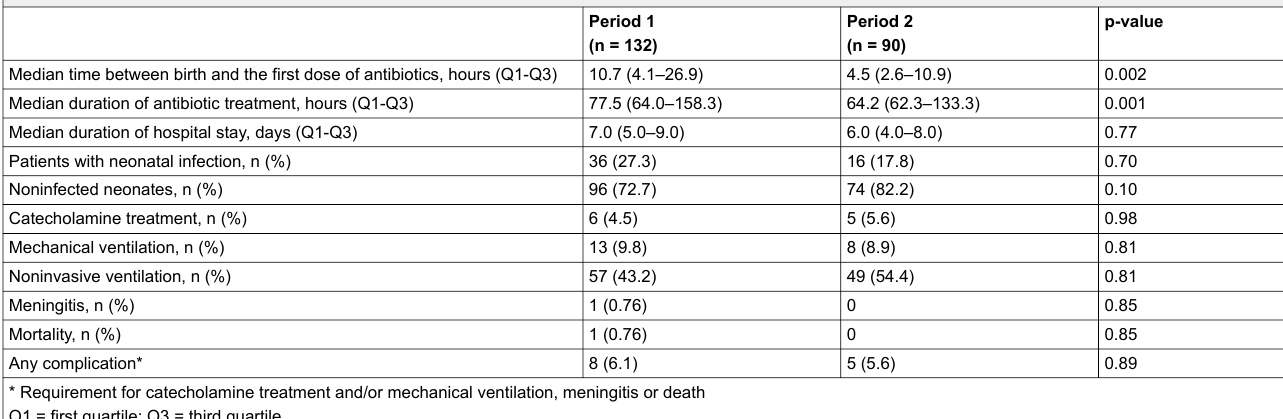
Table 2 : Clinical characteristics of the newborn infants treated with antibiotics.